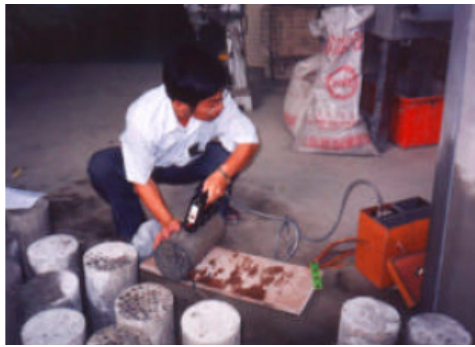
Figure 4. Electrical resistance test.